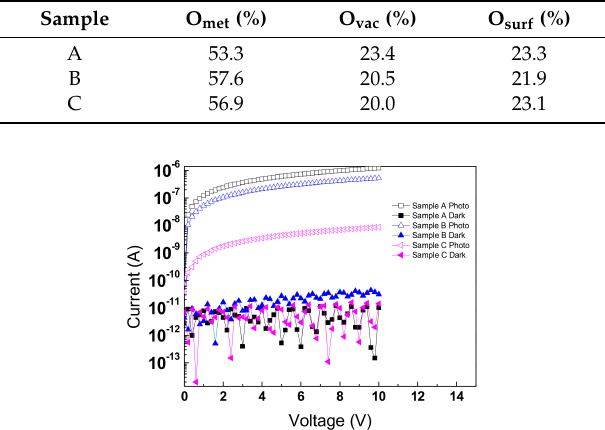
Figure 4. I – V characteristics of the three GaZTO photodetectors measured in the dark and under 280 nm UV